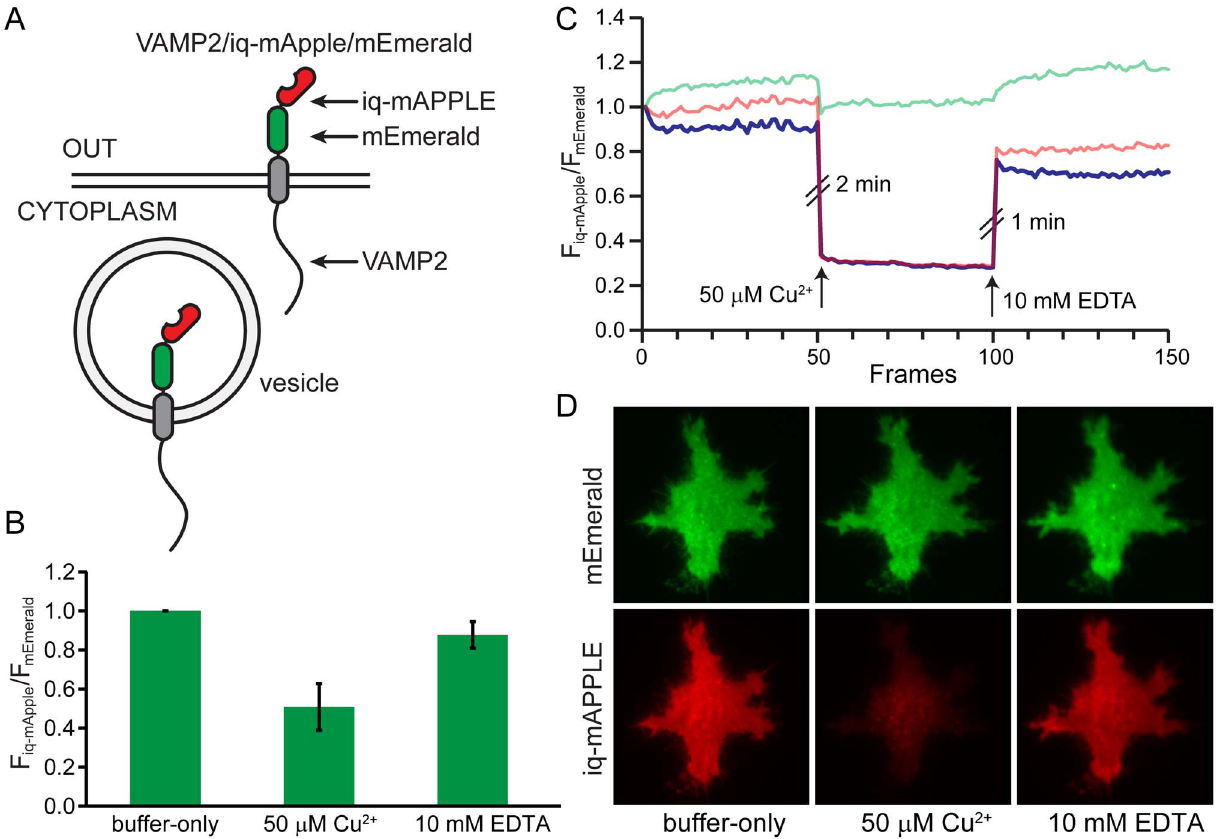
Figure 4. Invivo metal quenching experiment with VAMP2/iq-mApple/mEmerald probe. A) A cartoon representation of the construct. The chimeric biosensor iq-mApple/mEmerald is fused to the C-terminus of the membrane protein, VAMP2. A fraction of the sensors are located outside the cell and some are located inside exocytic/endocytic vesicles. B) The fluorescence quenching of VAMP2/iq-mApple/mEmerald by 50 m M Cu 2 + and its recovery by 10 mM EDTA. Error bars are S.D. C) A representative fluorescence intensity traces with the addition of 50 m M Cu 2 + and 10 mM EDTA. The raw fluorescent intensities are colored in green and red for two channels and the green/red radio is colored in blue. D) TIRF images from the experiment shown in Fig. 4C.